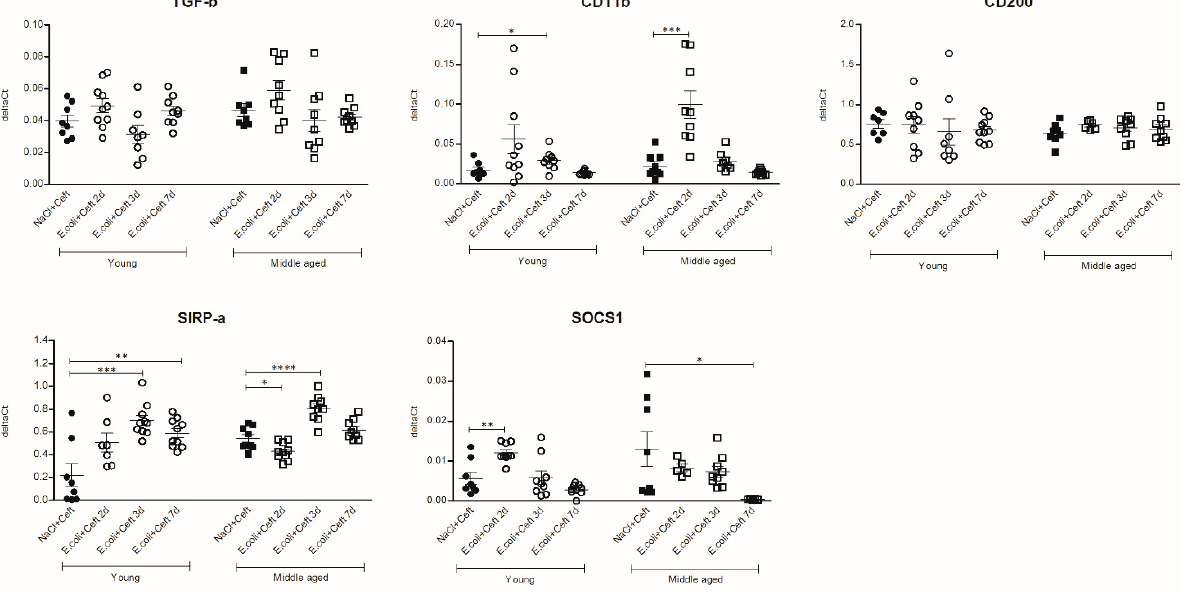
Figure A4. Bacterial outgrowth in cerebral spinal fluid (CSF), blood, spleen and liver per time point in colony-forming units per mL (CFU/mL) of all E. coli -infected mice. Note that all mice received ceftriaxone at 12 h and 1 day after inoculation. The red dotted line is the lower limit of detection (LLD), LLD for CSF is 2000 CFU/mL, LDD for blood is 20 CFU/mL and LDD for spleen and liver is 100 CFU/mL. Mann–Whitney U tests were performed, data represent mean ± SEM, *** p ≤ 0.001,